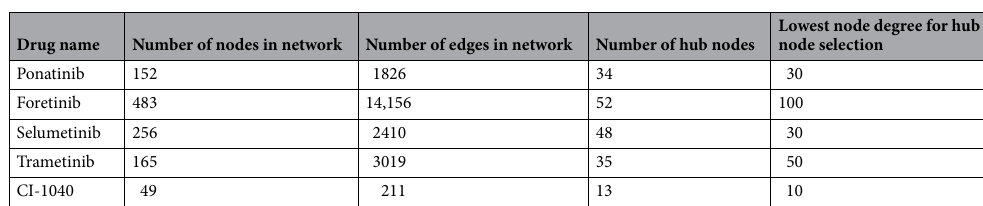
Table 1. List of number of nodes/edges and identified hub nodes in gene co-expression network for each of the five drugs.